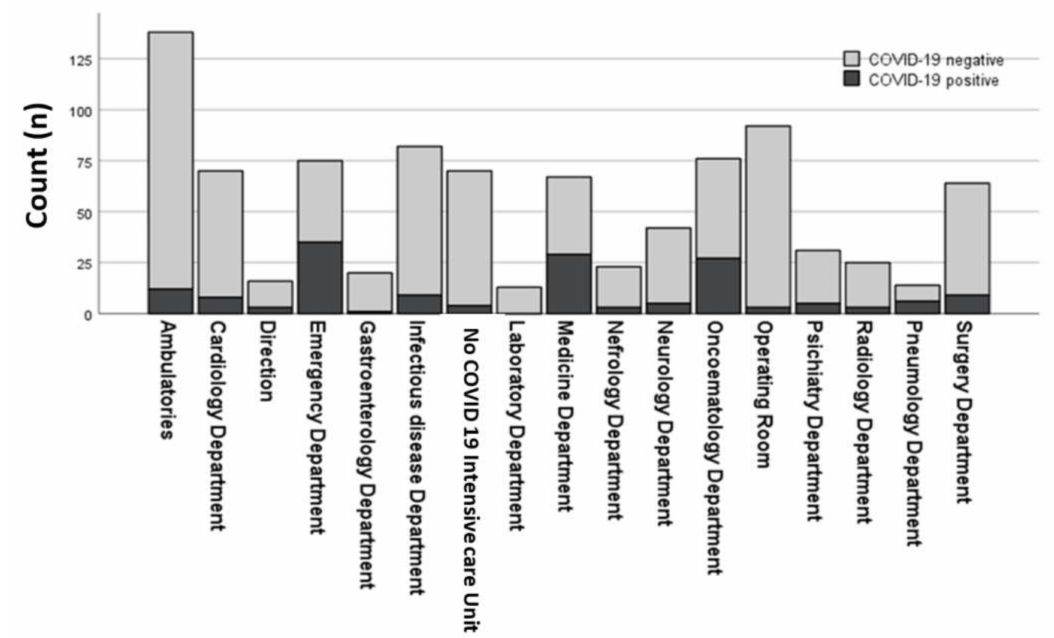
Figure 1. Number of COVID-19 nurses (positive and negative) in study population divided according to hospital